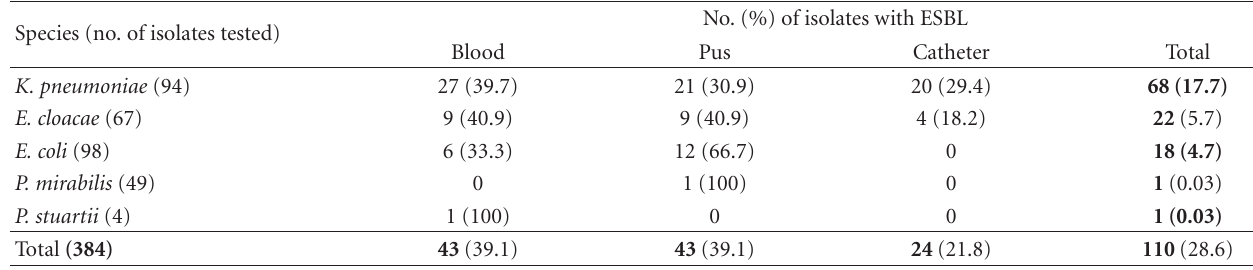
Table 1: Species and samples distribution of ESBL-EB ( N =